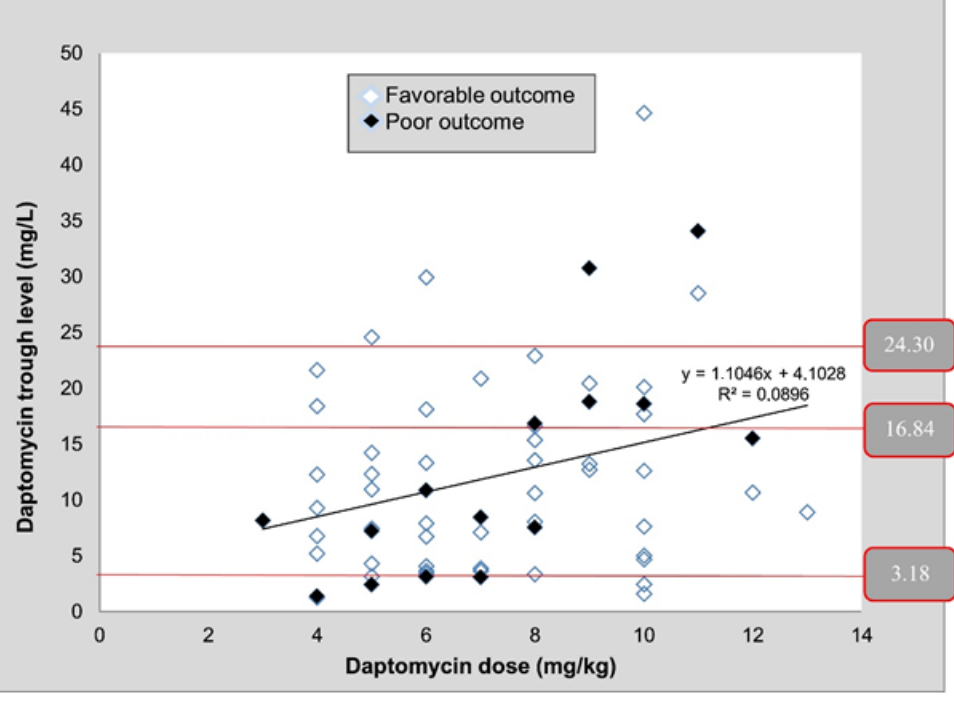
Figure 5. Correlation of daptomycin dose through serum level (C min) and clinical outcome [59].